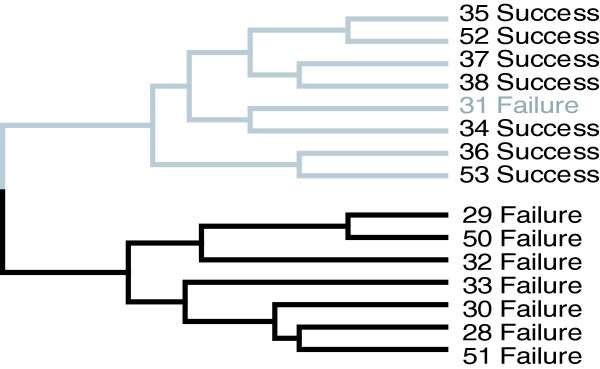
Detection of a sub-grouping of AML samples that clearly separates "Failure" vs. "Success" cases along with supporting genes. Note that informative genes which support this separation are selected solely based on their discrimination capacity with respect to AML vs. ALL classification and not for the discrimination of "Failure" vs. "Success" samples.